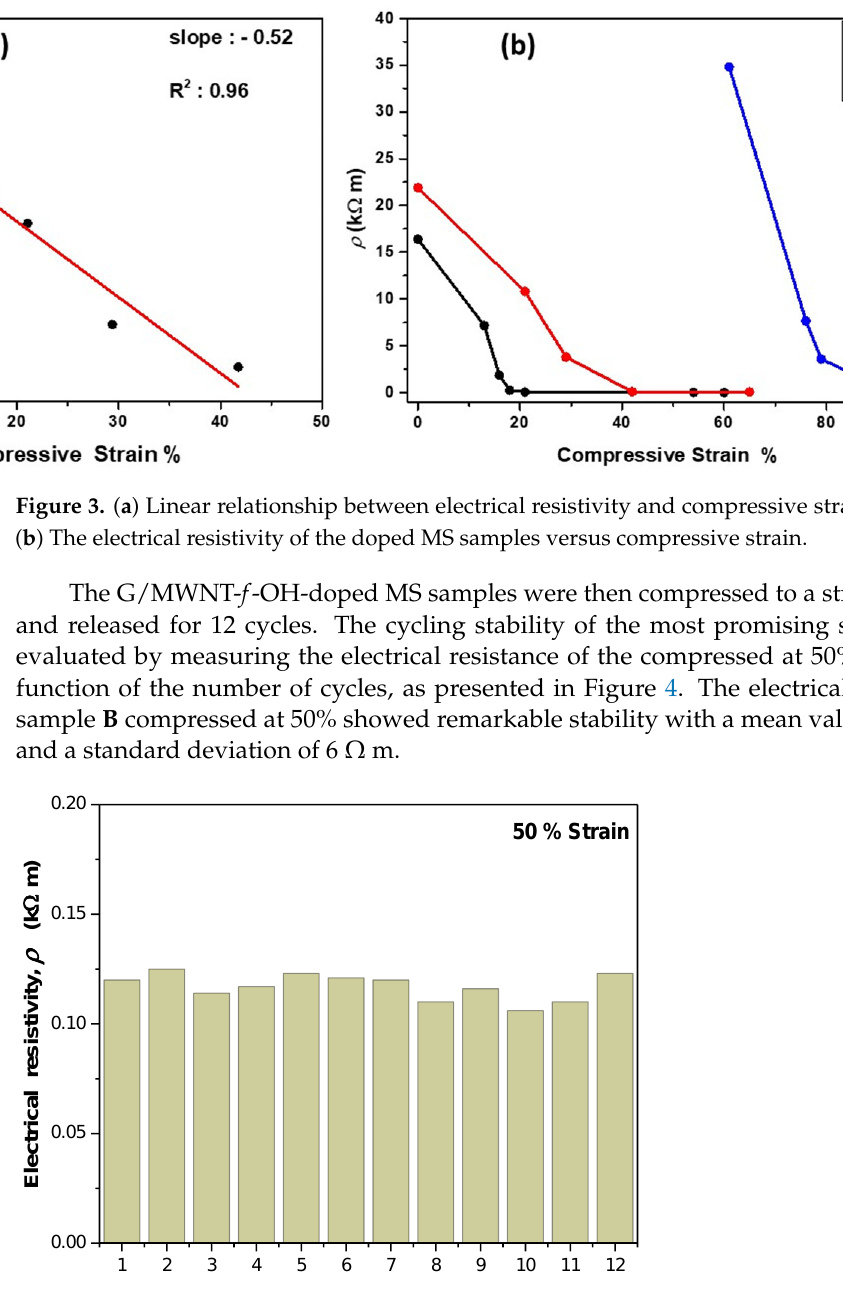
Figure 4. Stability of the electrical resistivity of sample MS B , at a compressive strain of 50%. The promising electromechanical behavior of sample B was highly favorable for its use as a piezoresistive sensor. Piezoresistivity is a common sensing mechanism where the electrical resistivity of a structure changes during a mechanical strain of the structure